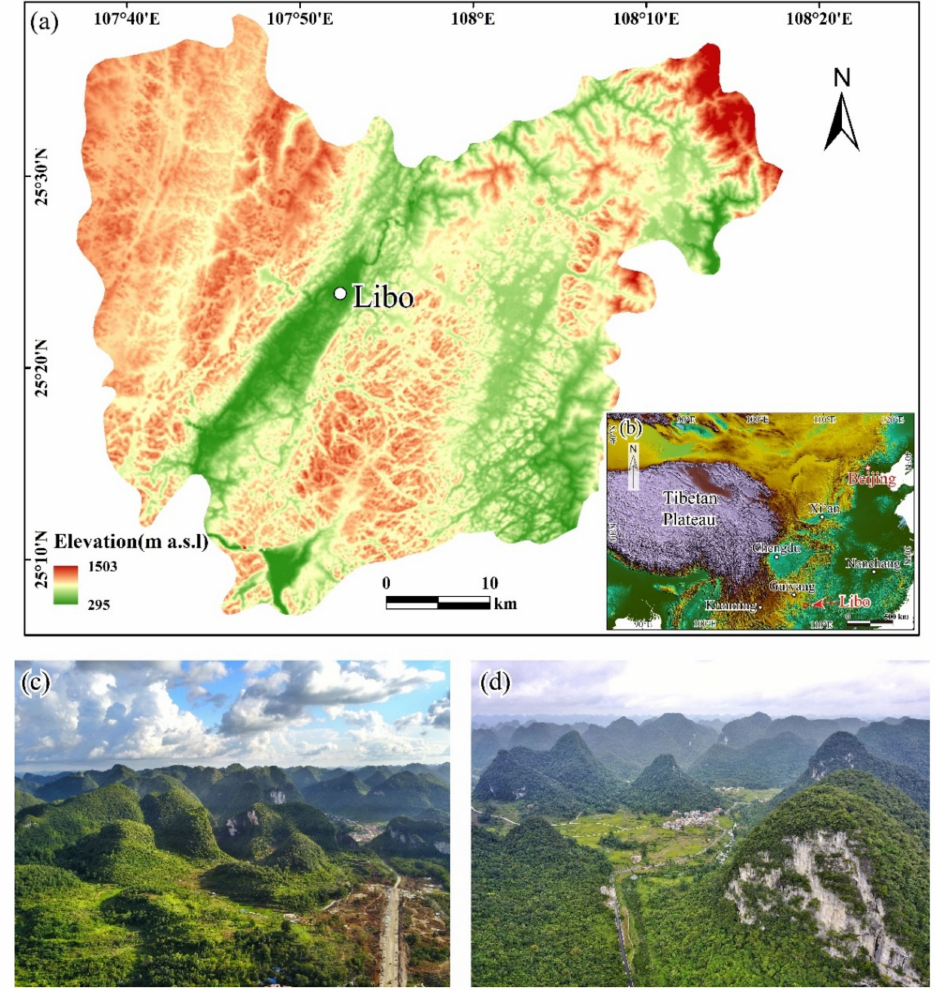
Figure 1. ( a ) ASTER GDEM image showing the topographic features of Libo area. ( b ) An index map showing the geographical location of study area. ( c , d ) Two images acquired by Unmanned Aerial Vehicle (UAV) over the typical cone karst landscape in Libo heritage site. It represents the world’s most spectacular cone karst landscape, which satisfies the evaluation standards of Articles VII and VIII of the World Heritage and has extraordinary aesthetic value and scientific research values